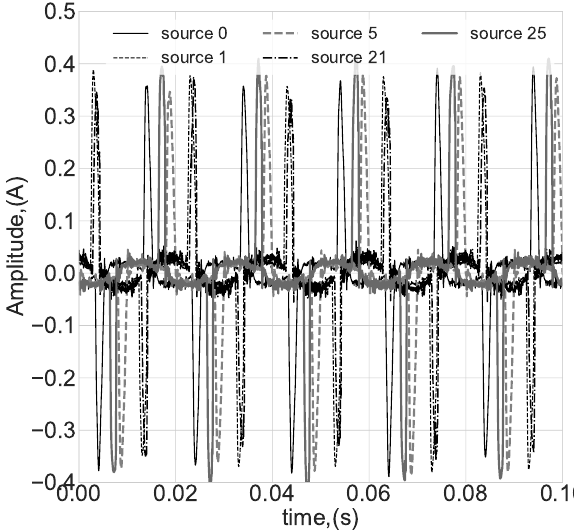
Figure 4. Typical segments of data for some sources